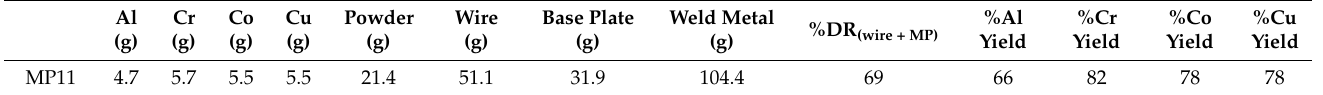
Table 3. Mass balance numbers and percentage yield calculation results for Al, Co, Cr and Cu.